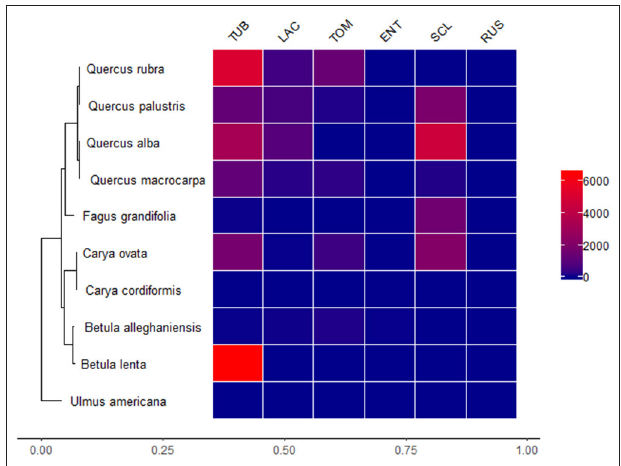
FIGURE 5 | Heatmap representing relationships between ectomycorrhizal fungi genera and the experimental tree species. Heatmap values indicate cumulative edge R normalized scores for each fungal genus in our OTU matrix. Ectomycorrhizal fungi taxa are TUB ( Tuber ), LAC ( Laccaria ), TOM ( Tomentella ), ENT ( Entoloma ), SCL ( Scleroderma ), and RUS ( Russula ). Red values are greater normalized abundances and blue colors are lower normalized